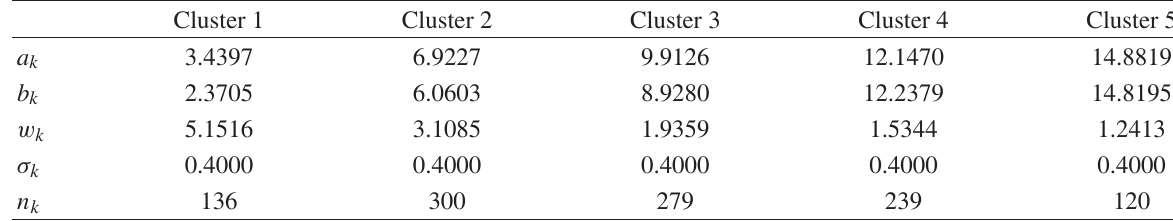
TABLE 2: Parameters for synthetic